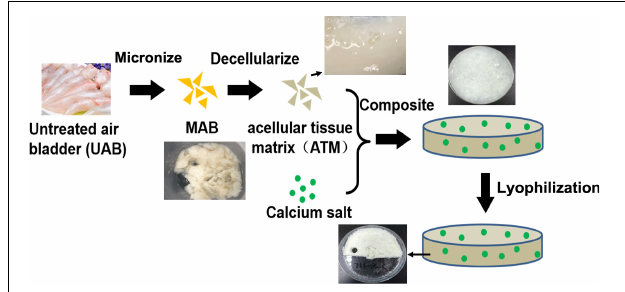
FIGURE 1 | Schematic for air bladder derived composite scaffold fabrication: A Fish air bladder was cleaned then micronized using a knife mill to form microfibers. The microfibers were decellularized through a series of detergent treatment and washing steps to receive acellular tissue matrix (ATM). Next, dicalcium phosphate (DCP) microparticles were mixed and homogenized with ATM to form DCP/ATM composite. The final composite scaffold was obtained via